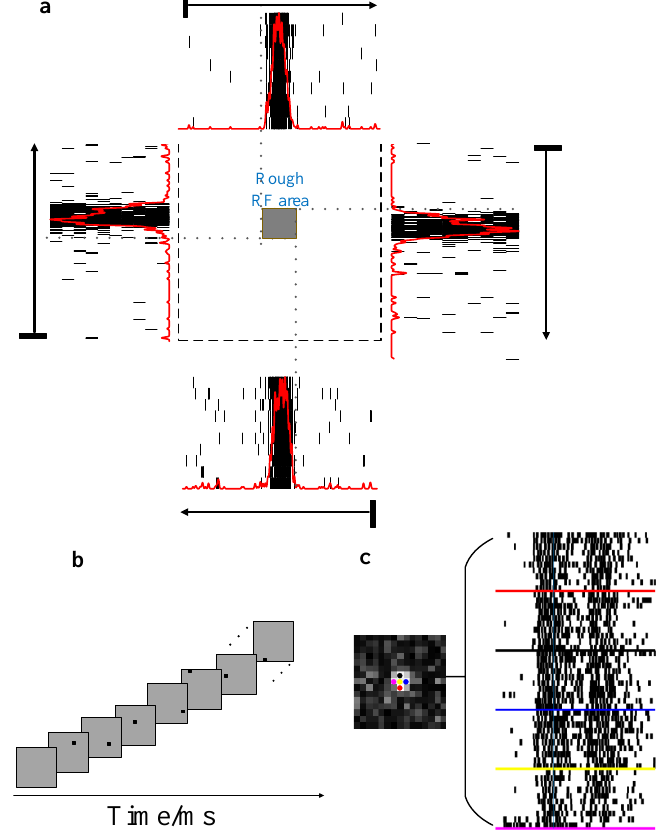
Figure 3. Receptive fields of a recorded unit. ( a ) Rough receptive field area was estimated with the paradigm of a long bar moving from one side to the other side over the screen. The adjacent surrounding arrows denote the moving direction of the bar. The outer surroundings present the firing spike train and post-stimulus time histograms of the moving bar in each direction for 20 repetitions. ( b ) Paradigm of sparse noise flashed inside the rough receptive fields area. ( c ) A detailed receptive field was measured, with the grey levels representing the number of spikes evoked by the stimulus, and then the bright area was selected as the center of the receptive fields. The right five subfigures show ten repeats of the firing spike train corresponding to the location indicated with the same color.